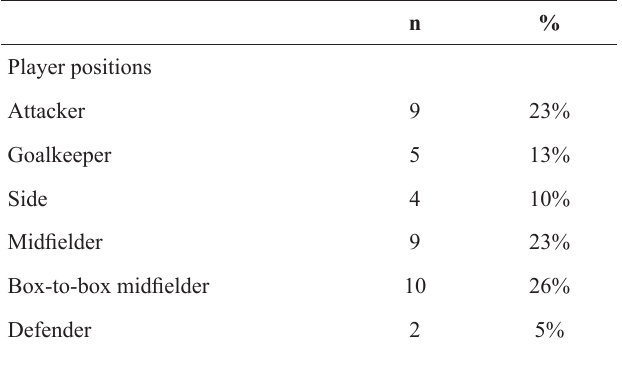
Table 1. Distribution of Sergipe and Confiança 2014 football male athletes according to characteristics and conditions of